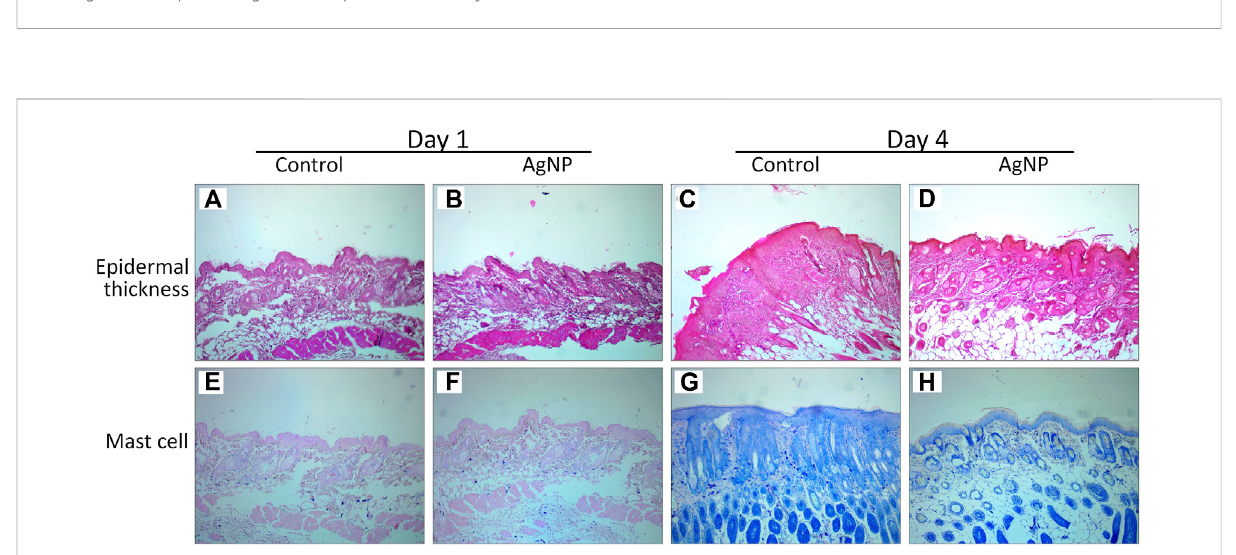
EffectofAgNPonhistologicfeaturesofthewoundat1and4 days: (A,C) H&Estainingoncontrolgroup; (B,D) H&Estainingontreatmentgroup; (E,G) Toluidine blue staining on control group; (F,H) Toluidine staining on treatment